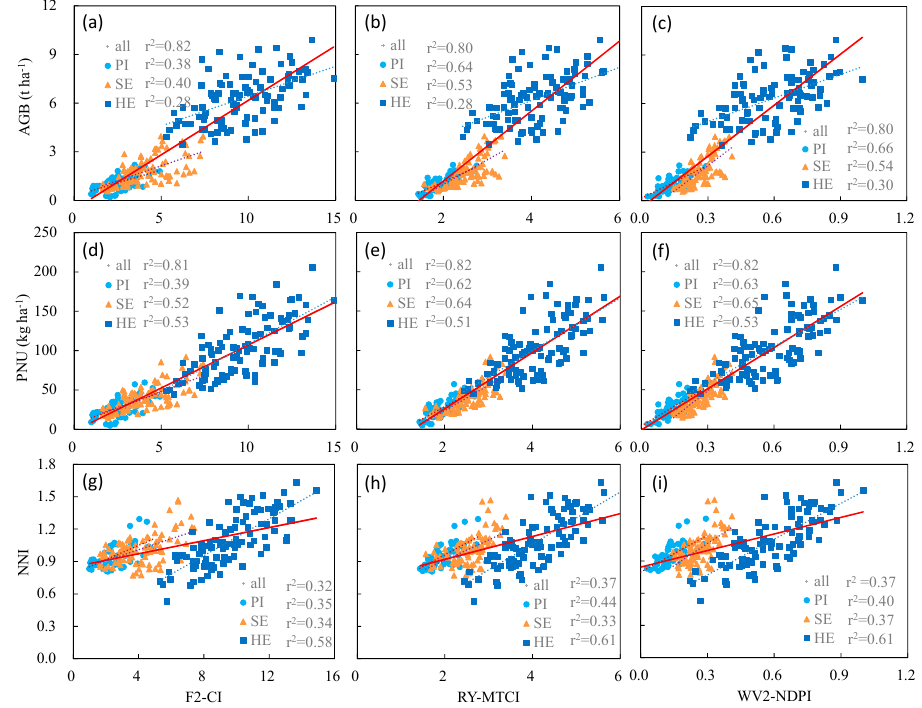
Figure 2. Relationships between: FORMOSAT-2-based Chlorophyll Index (CI) ( a ); RapidEye-based MERIS Terrestrial Chlorophyll Index (MTCI) ( b ); WorldView-2-based Nitrogen Planar Domain Index (NDPI) ( c ), and aboveground biomass (AGB); FORMOSAT-2-based CI ( d ); RapidEye-based MTCI ( e ); WorldView-2-based NDPI ( f ), and plant N uptake (PNU); and FORMOSAT-2-based CI ( g ); RapidEye-based MTCI ( h ); WorldView-2-based NDPI ( i ), and N nutrition index (NNI), at the panicle initiation (PI), stem elongation (SE), heading (HE), and across all stages. The relationships between VIs and N status indicators across growth stages are indicated by the red lines.